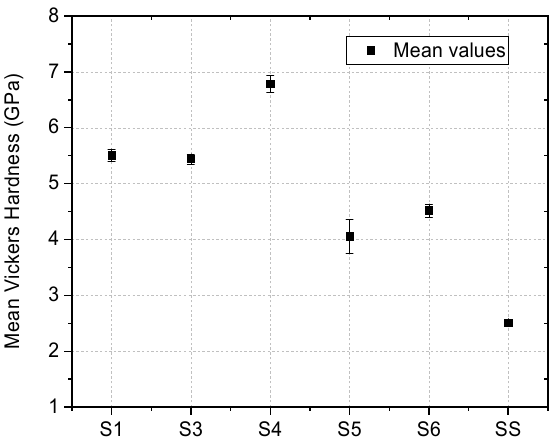
Figure 10. Vickers microhardness results for HV 0.01 load; S4 film expressing the highest hardness coefficient.